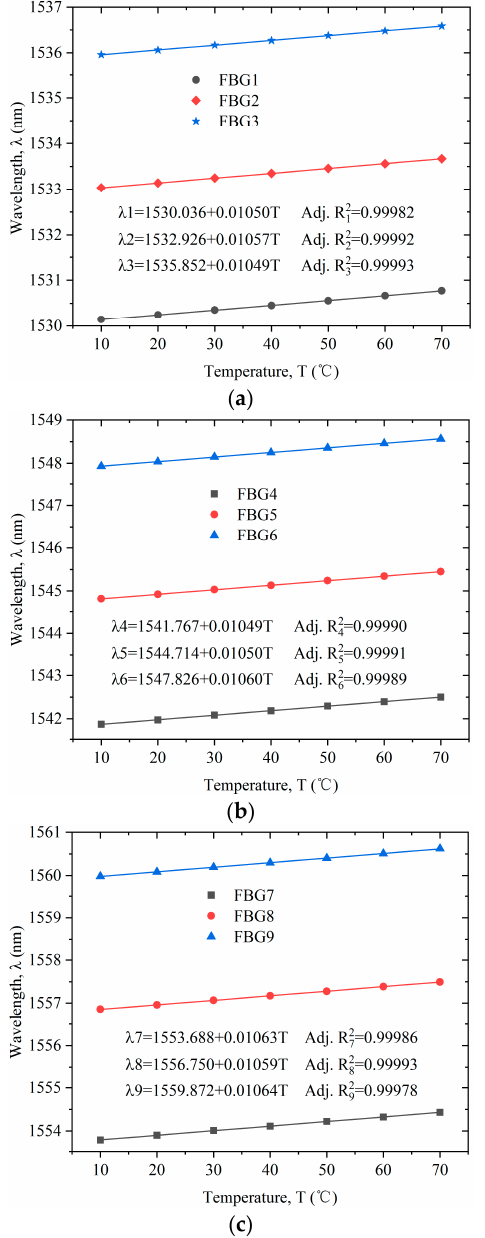
Figure 6. Calibration curves of the FBG sensors: ( a ) FBG1–FBG3; ( b ) FBG4–FBG6; ( c ) FBG7–FBG9.